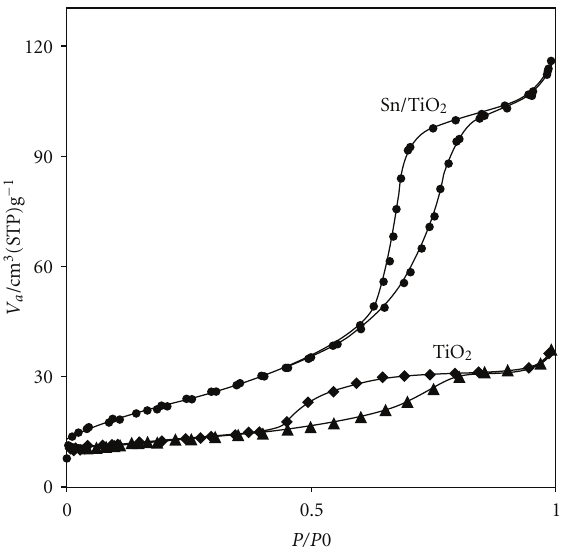
Figure 5: Pore diameter distribution of 1.5mol% Sn/TiO 2 .